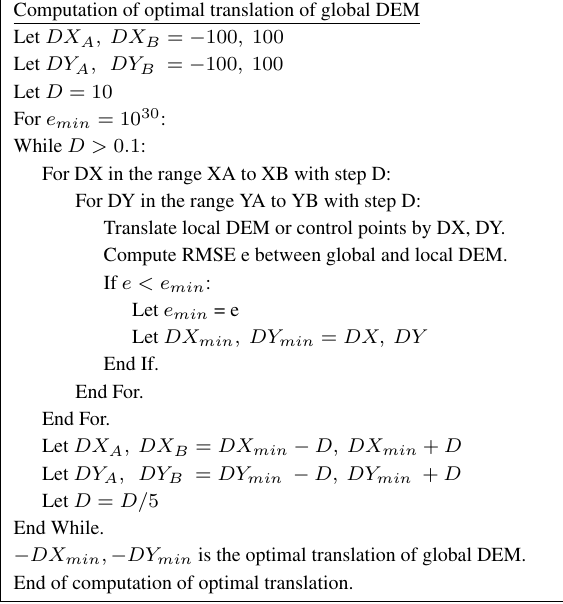
Figure 3. Exhaustive search/Divide-and-Conquer algorithm.